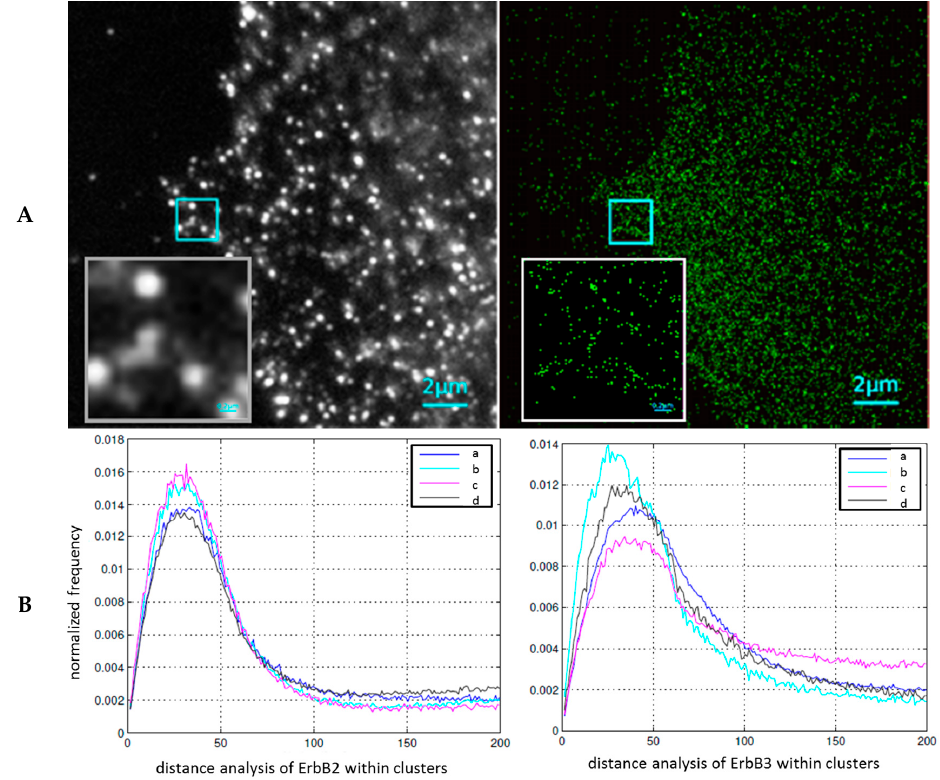
Figure 2. ( A ) Image section of a breast cancer cell (MCF7 cell line) after specific labelling of ErbB3: Widefield image ( left ), image obtained from localization microscopy data ( right ). The inserts are magnifications of a section of 2 μ m × 2 μ m. ( B ) Relative frequency distributions of receptor to receptor distances within the detected clusters of ErbB2 ( left ) and ErbB3 ( right ); for comparison see Figure 1B: (a) non-treated control; (b) after neuregulin-1 treatment of ErbB3; (c) after neuregulin-1 stimulation of ErbB3 and trastuzumab treatment of ErbB2; (d) after neuregulin-1 stimulation of ErbB3 and combined treatment of ErbB2 with trastuzumab and pertuzumab. For each curve, 21–25 cells were analyzed and merged. The number of points showed a variety of about 30–35% between the individual cells. ErbB2 and ErbB3 receptors were partly organized in clusters of typically 70–90 nm in diameter.